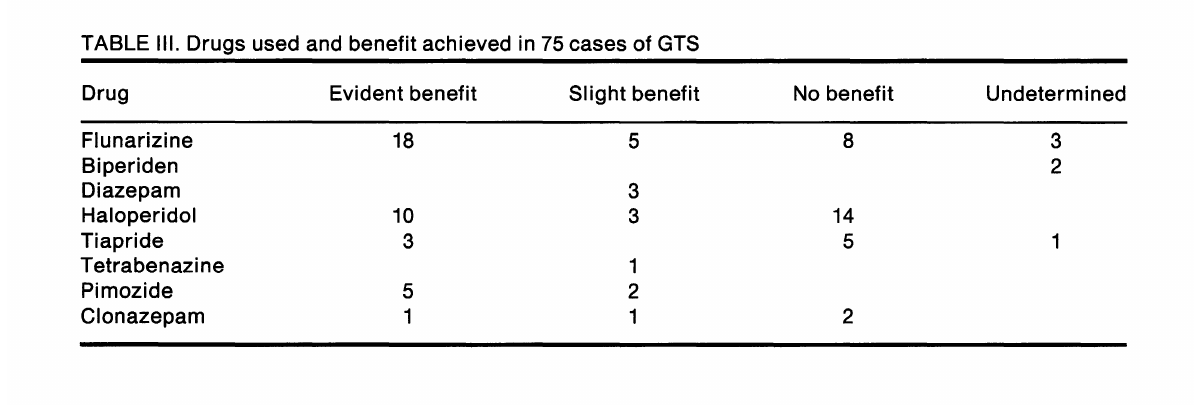
TABLE III. Drugs used and benefit achieved in 75 cases of GTS